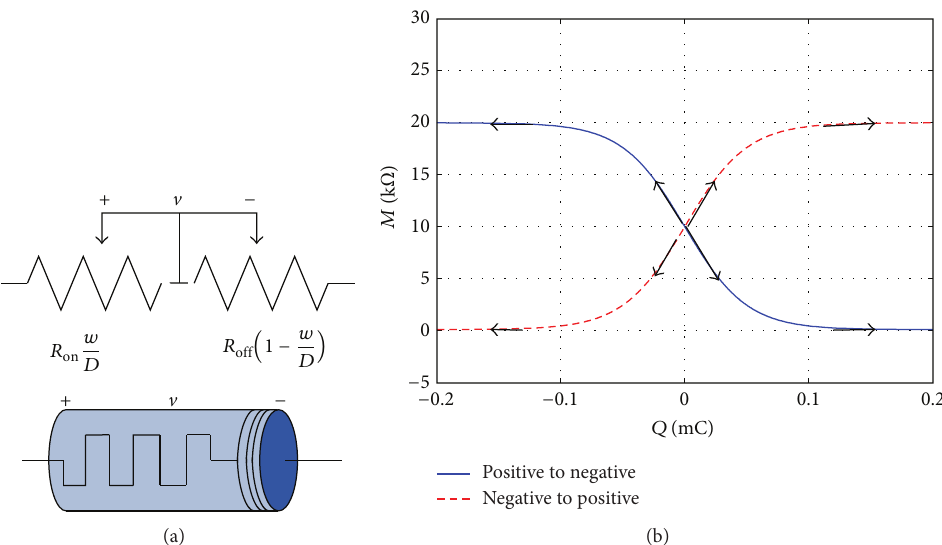
Figure 3: The nonlinear memristor model and its characteristic curves. (a) The equivalent circuit of the memristor and its 3D symbol. (b) The relationship between memristance and the charge.